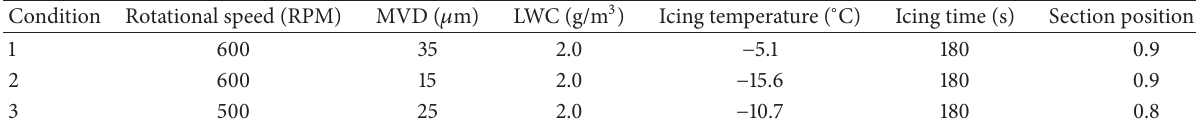
Table 1: Calculation and experimental conditions in [16].